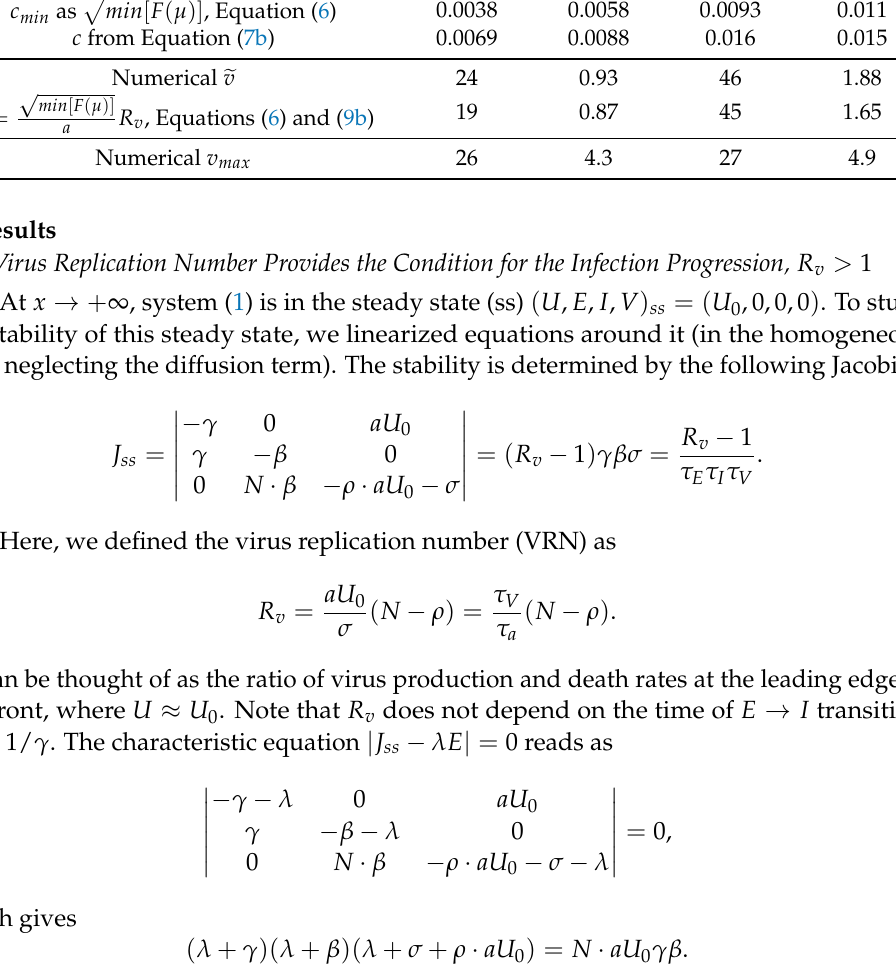
) , spatially integrated viral concentration (cid:101) v ( 10 6 cells ) and maximal Table 2. Autowave speed c ( cm h cm 2 ) for Delta and Omicron steady spatial autowave propagation. viral concentration v max ( 10 6 cells mL Delta Omicron Delta Omicron ρ = 1 ρ = 0 Numerical